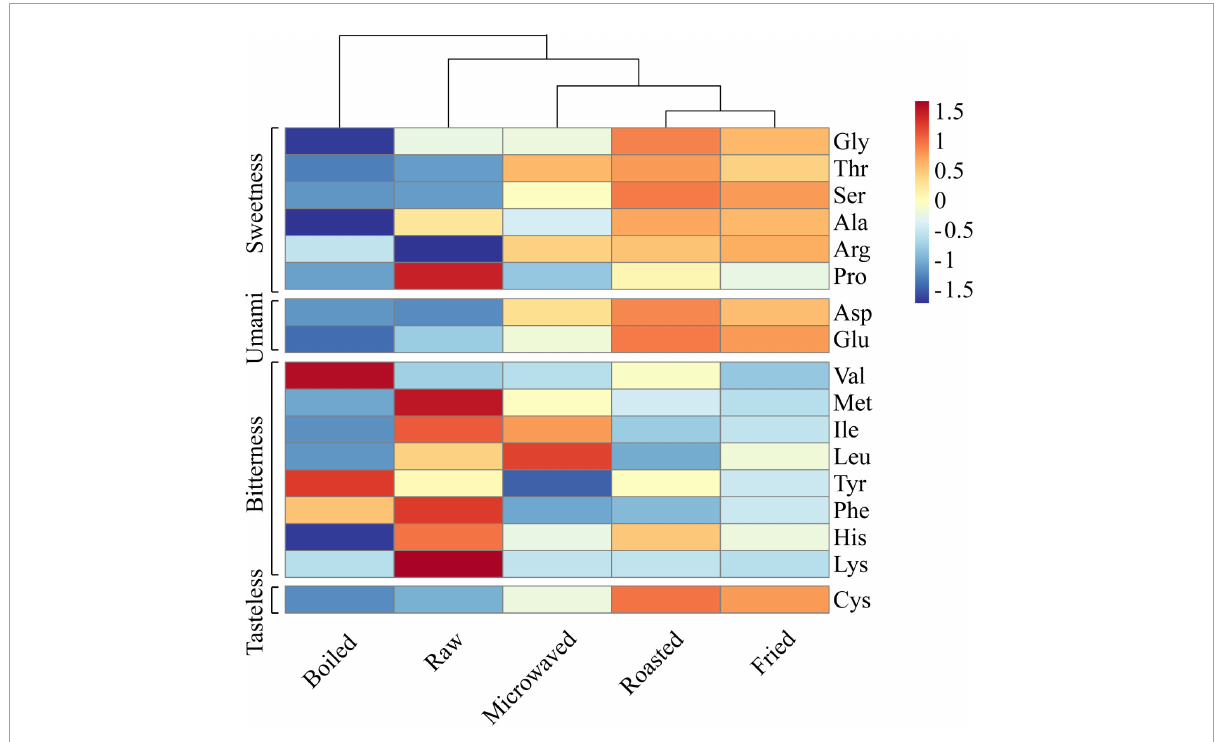
FIGURE2 Heat map clustering of free amino acids in raw and cooked